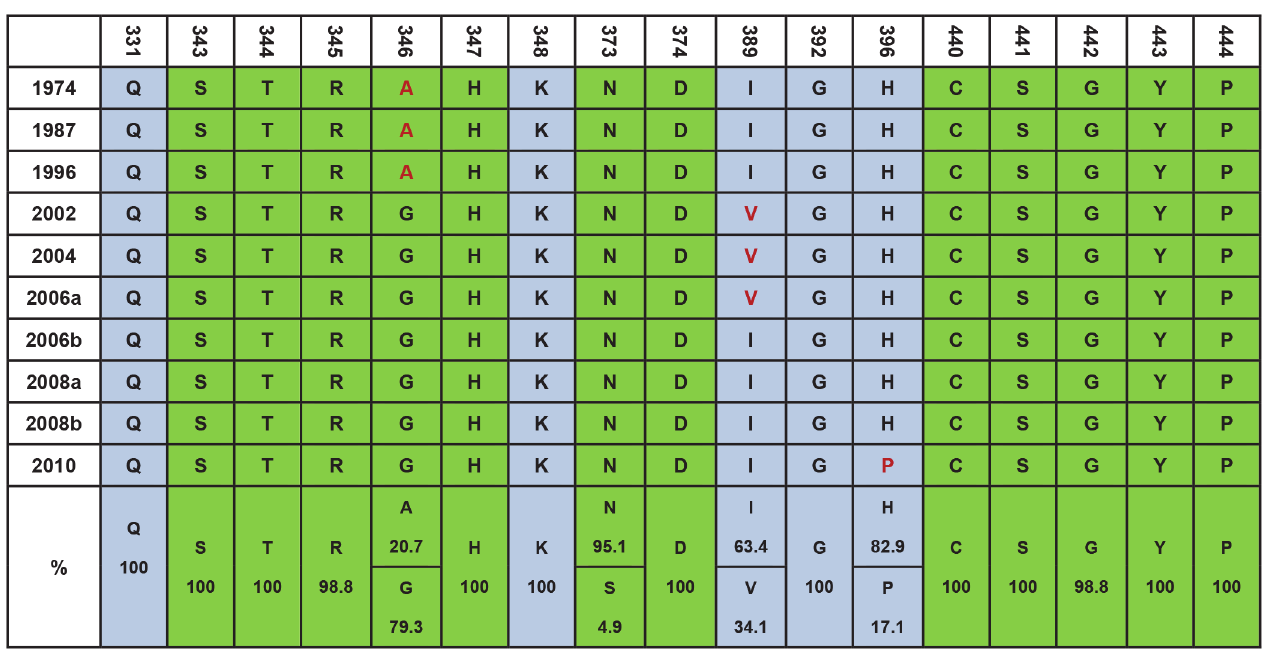
Fig 1. Phylogenetic tree of GII.4 norovirus P domain sequences. Multiple alignments were generated using 82 P domain amino acid sequences with MegAlign Lasergene software and the phylogenetic tree was generated using the neighbor-joining method in MEGA (version 4.1). GII.4 sequences from 1974 to 2012 grouping in different clusters are labeled. Strains isolated in this study are as follows: 2005Y2004C,